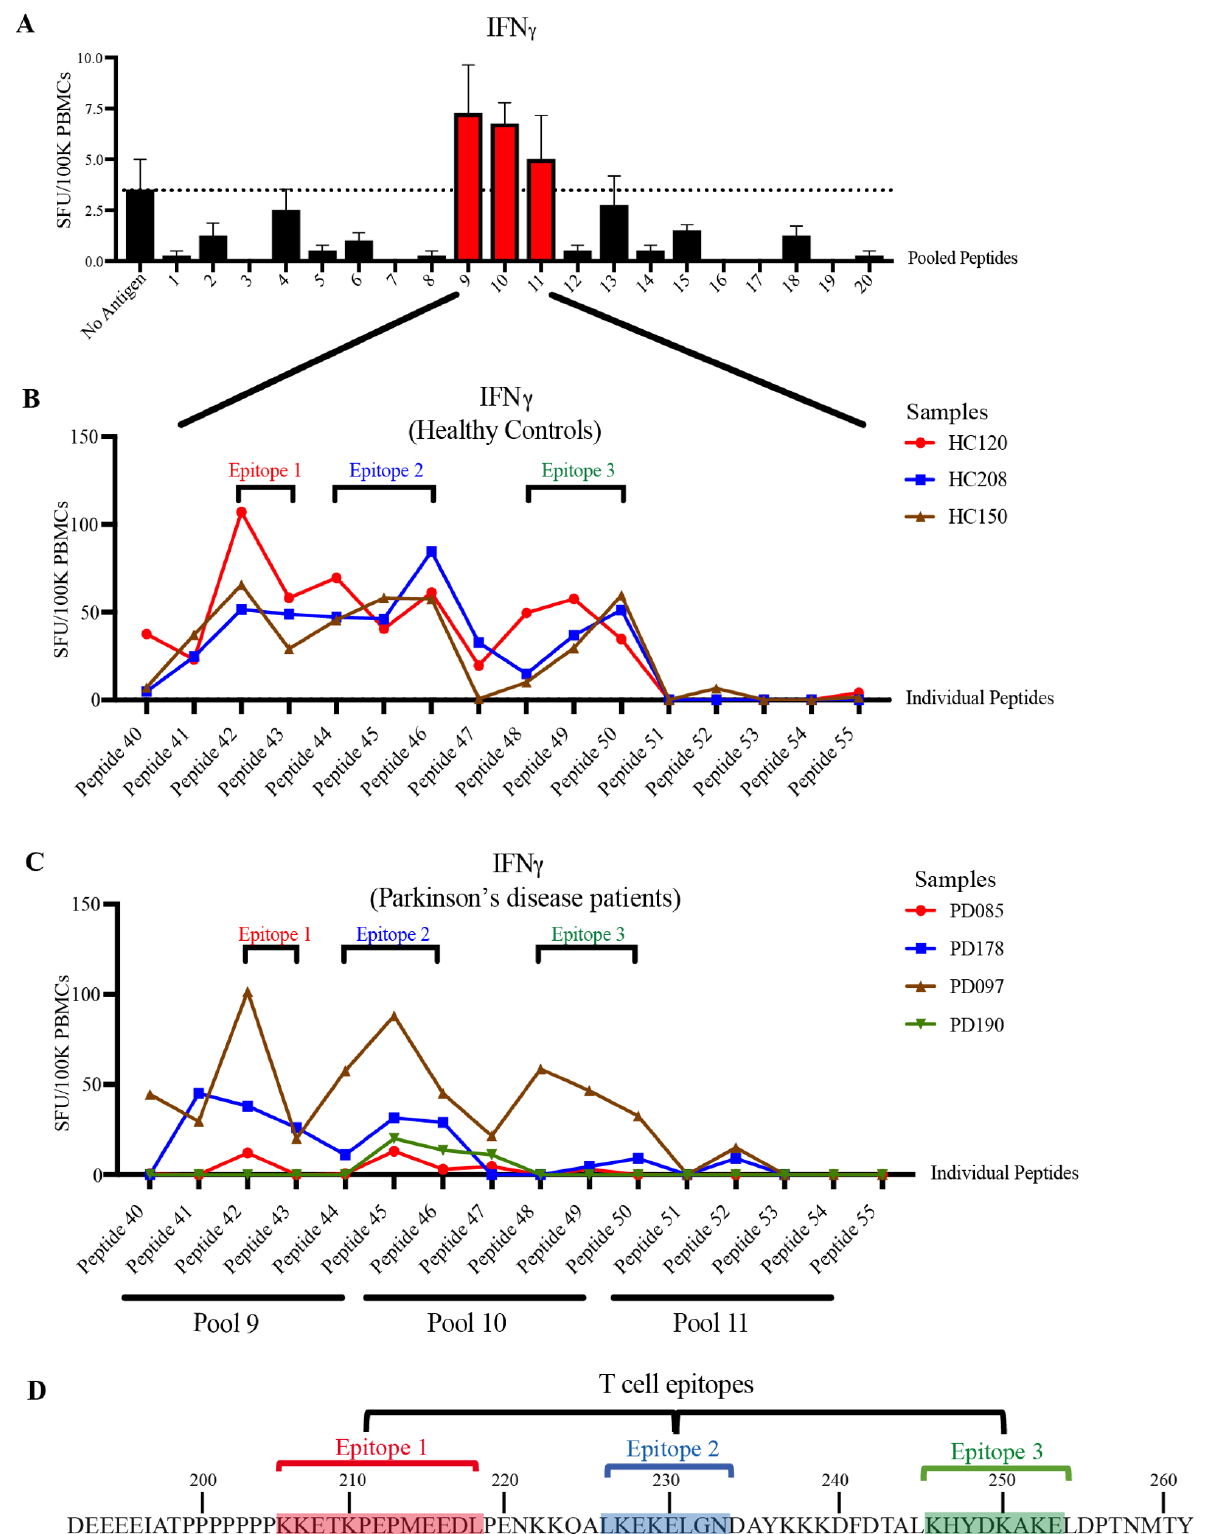
Figure 4. Characterisation of STIP1-specific T cell epitopes. PBMCs obtained from ( A ) healthy controls (HC) were stimulated with 5 µ g/mL of pooled peptides. Each pool contains 5–6 individual peptides from the STIP1 peptide library. The dotted line represents the average spot forming units (SFU) from the background, which are cells without antigen treatment. The SFU of interferon γ (IFN γ